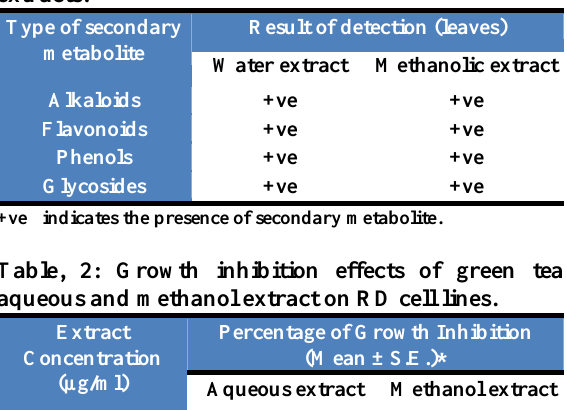
Table, 1: Some secondary metabolites detected in Cammellia sinensis water and methanolic leaf